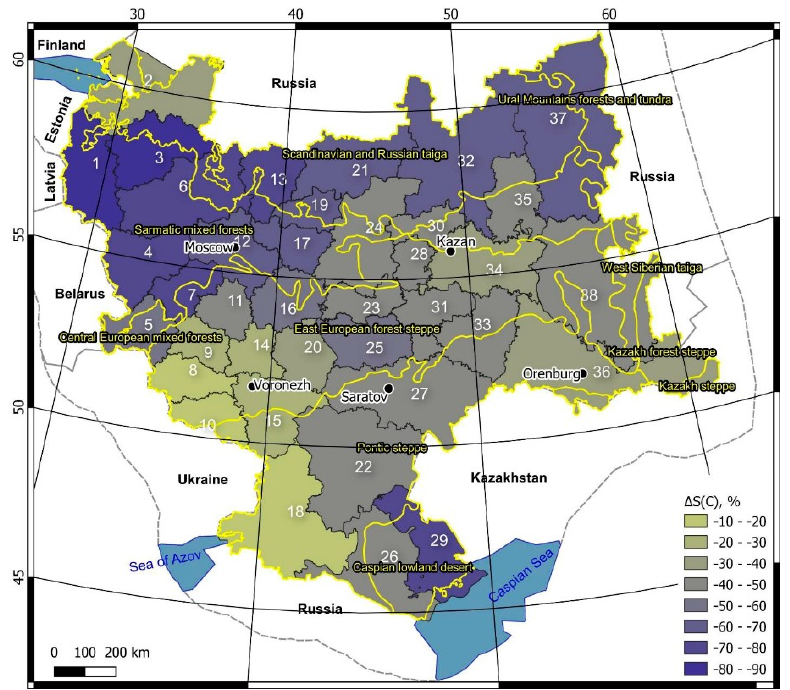
Figure 4. Relative reduction in cultivated land area under cereals ( ∆ S(C)) within the analyzed administrative regions of European Russia between 1970–1987 and 1996–2017. For other symbols, see Figures 2 and 3.